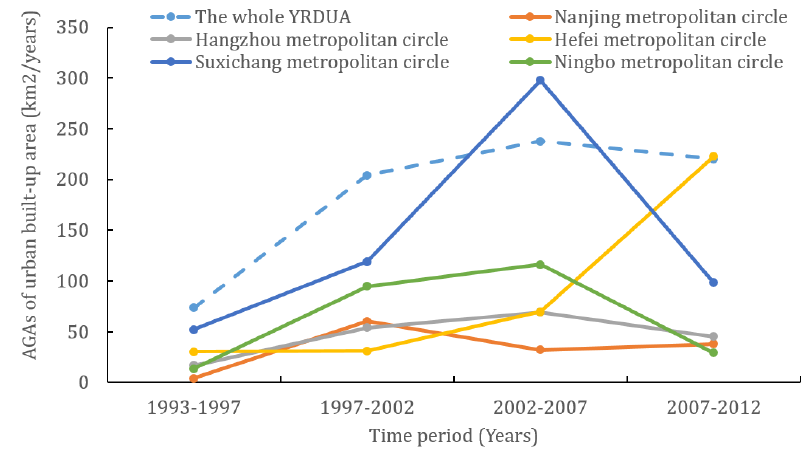
Figure 4 . Annual growth area (AGA) plots of the YRDUA urban built-up area for 1993 – 2012. Figure 4. Annual growth area (AGA) plots of the YRDUA urban built-up area for